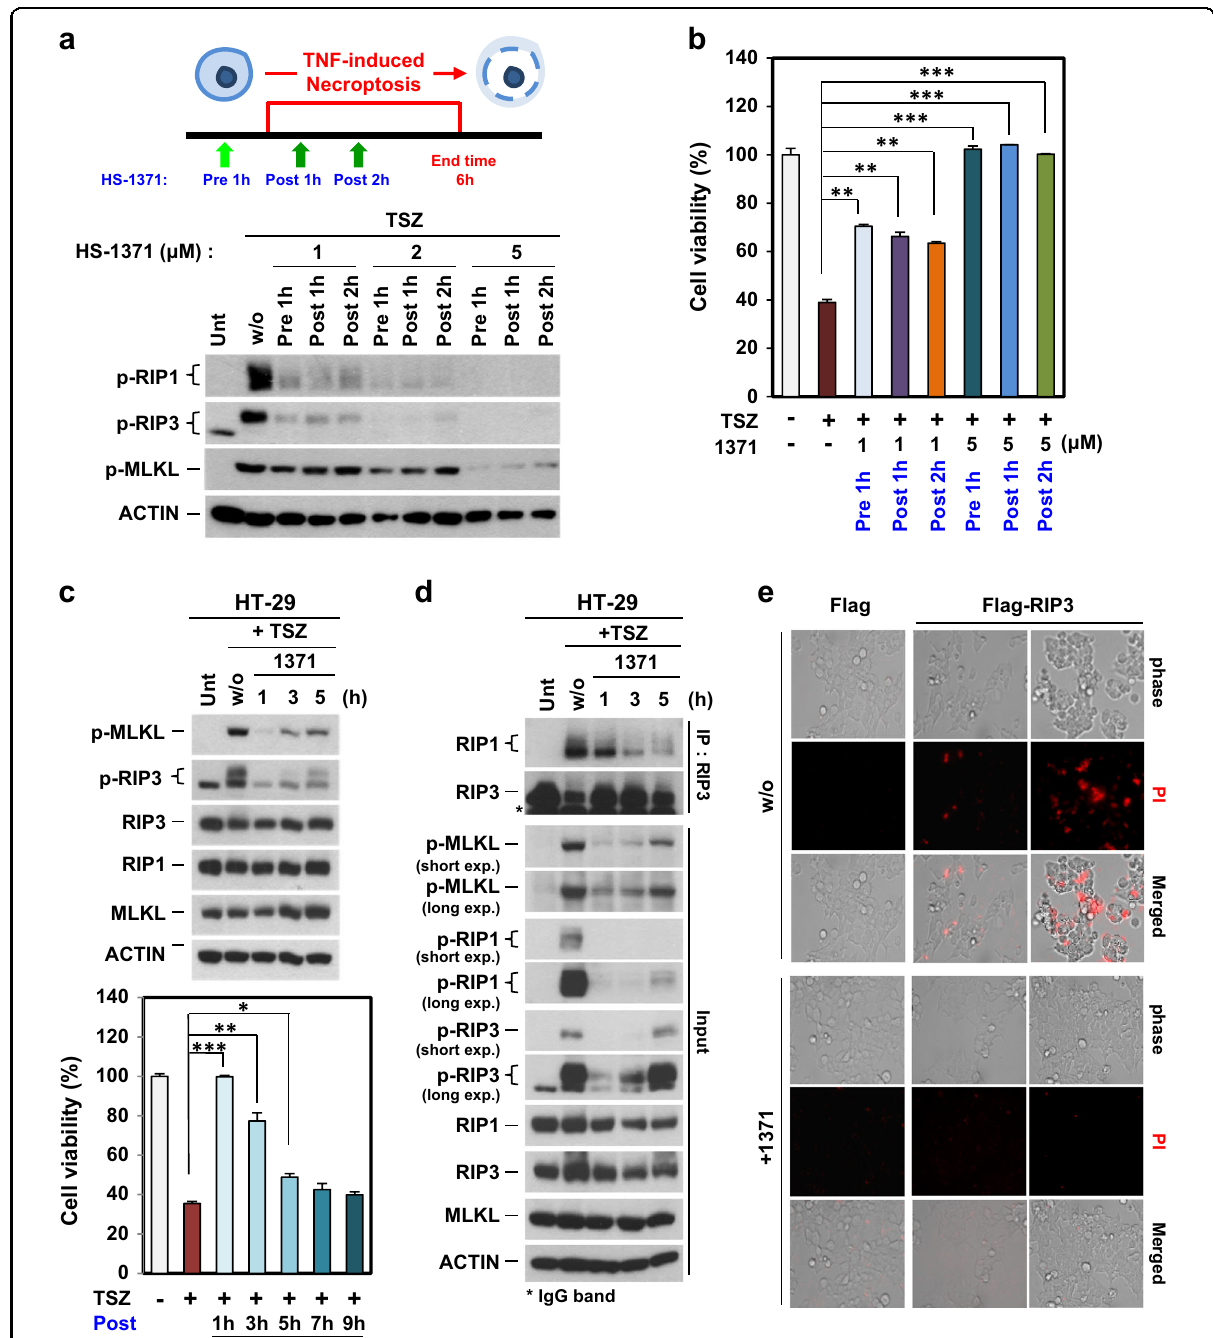
Fig. 6 Possibility of HS-1371 as a drug for necroptosis-related diseases. a , b HT-29 cells were pre- or post-treated with HS-1371 for indicated time points, and RIP3 phosphorylation ( a ) and cell death ( b ) were measured by western blotting or MTT assay. Data are presented as means ± SEM. * P < 0.05, ** P < 0.01, *** P < 0.001. c HT-29 cells were treated with TSZ and then post-treated with HS-1371 for indicated time points, and then cell lysates were analyzed by immunoblotting (upper panel). Cell viability was analyzed by MTT assay. Data are presented as means ± SEM. * P < 0.05, ** P < 0.01, *** P < 0.001. d Cells were treated with the same conditions as ( c ), and cell lysates were immunoprecipitated with anti-RIP3 antibody. Immunoprecipitates and total lysates were analyzed by Western blotting. e Upregulated RIP3 expression-induced cell death was inhibited by treatment with HS-1371. 293T cells were transfected with Flag vector or Flag-RIP3, and 20 h after transfection, cells were stained with PI. PI-positive cells were analyzed by phase-contrast fl uorescence